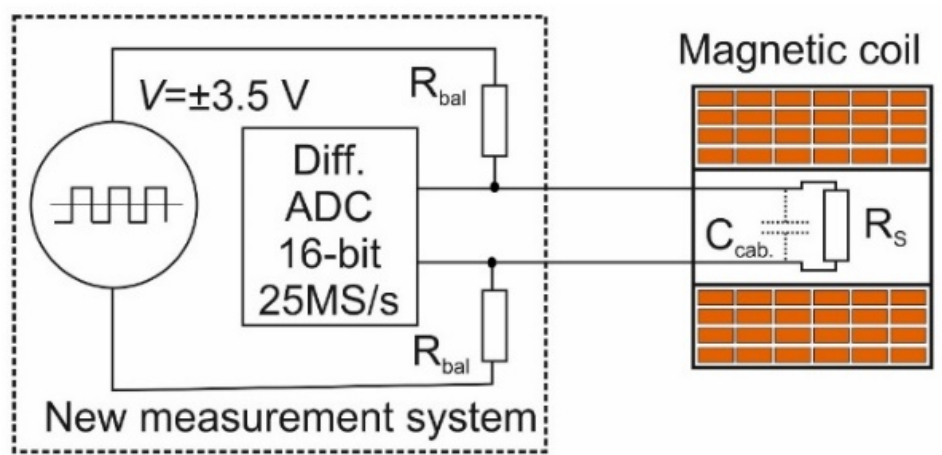
Figure 9. Block diagram of the new measurement system and magnetic coil used for testing and calibration of the sensor.